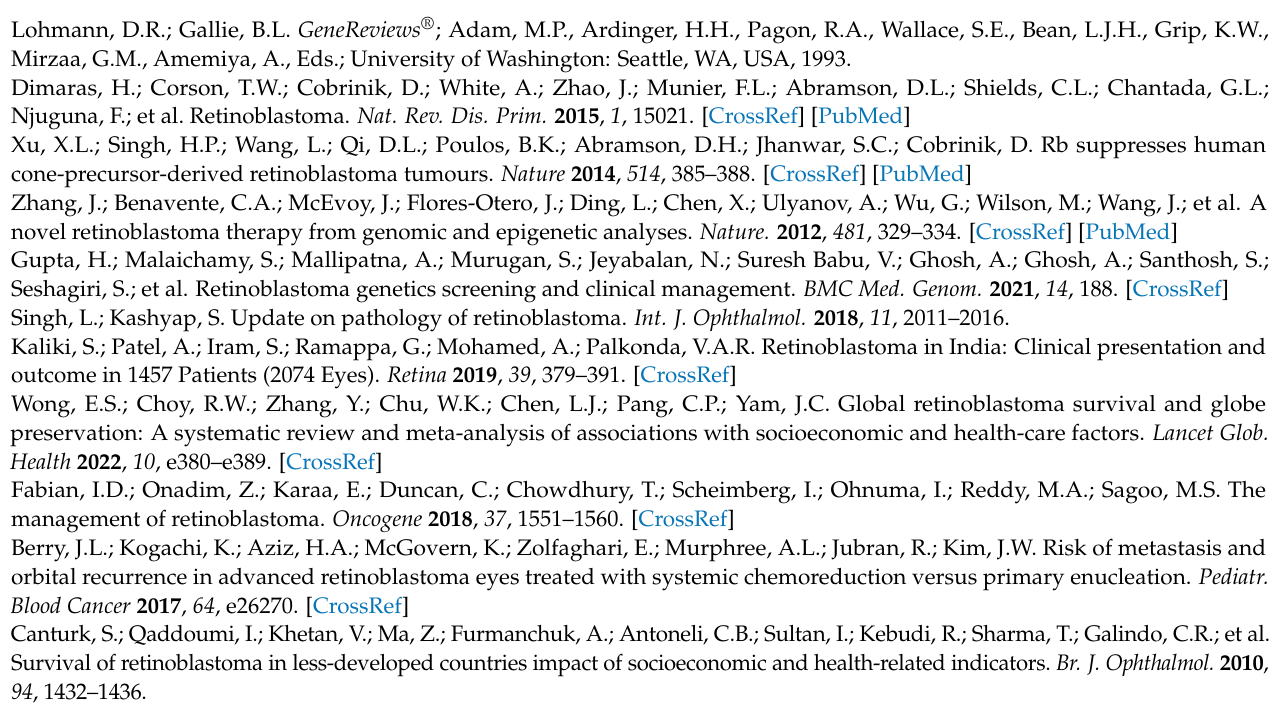
Figure S3: Pathways associated with Rb and in vitro models; Figure S4: Statistical decision tree. Table S1: Clinical and histopathological details of samples used for validation; Table S2: RT-PCR primer